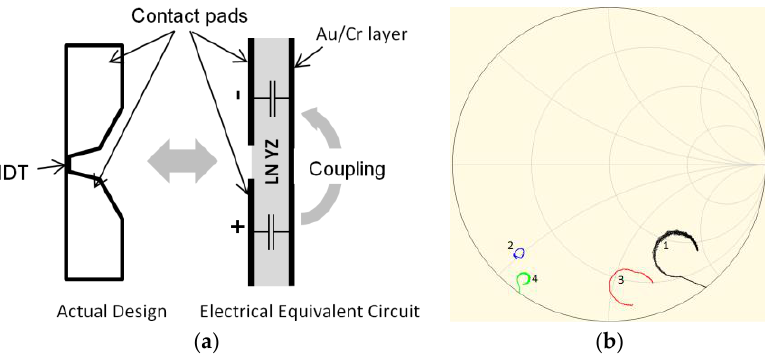
Figure 4. ( a ) Capacitive coupling issue between two connection pads of an IDT (red circles), in the presence of an Au/Cr bonding layer; ( b ) Effect, in the Smith chart, of the Pad-to-Pad capacitive coupling on the IDT impedance. Black (1): reference IDT, mounted on pure LN (no capacitive coupling); Blue (2): IDT with large pads; Red (3): IDT after reduction of the pads dimension, using Laser ablation; Green (4): calculated response of the reference IDT (black curve), shunted with two series 3.95 pF capacitors. A second issue arises from the use of the Au/Cr layer.